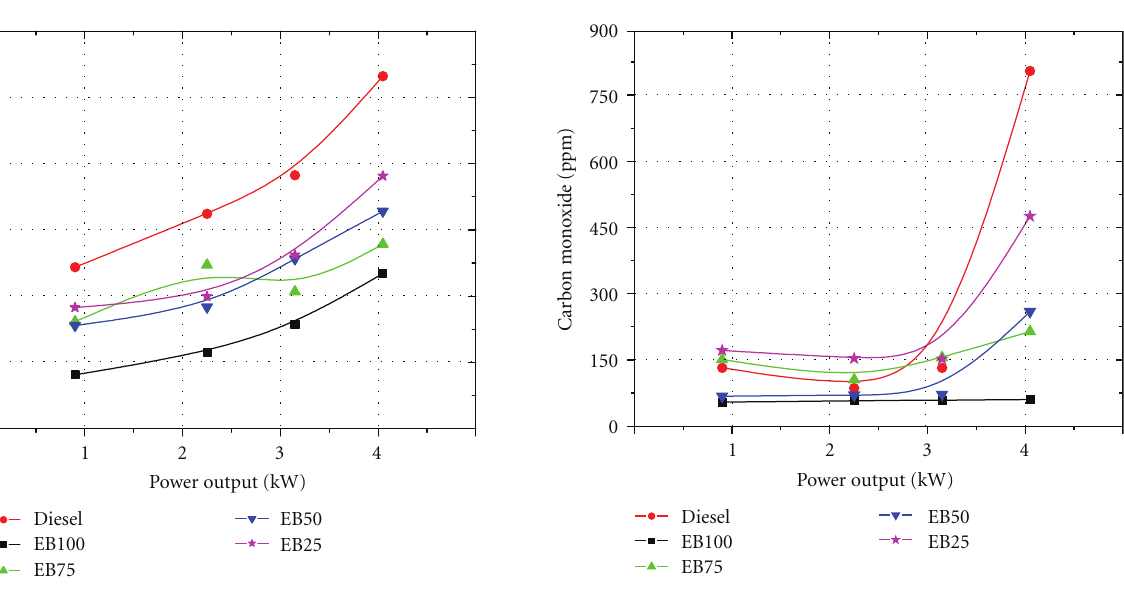
Figure 8: Carbon monoxide emissions at various power output.